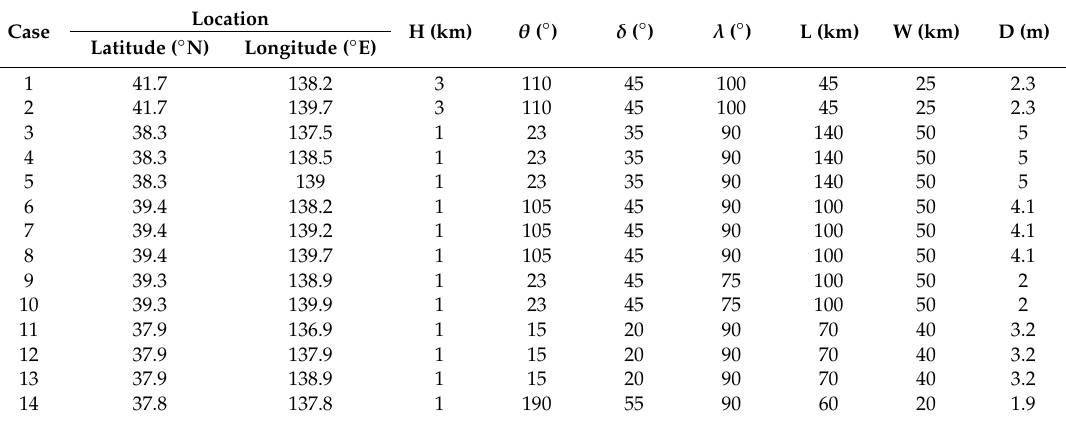
Table A1. Fault parameters for potential tsunami scenarios on the west coast of